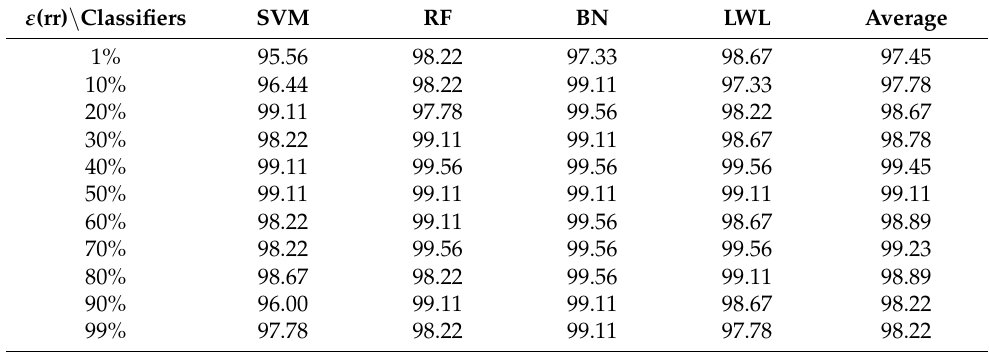
Table 5. The accuracy (%) of different thresholds ε (rr) under the four types of machine learning. ε (rr) \